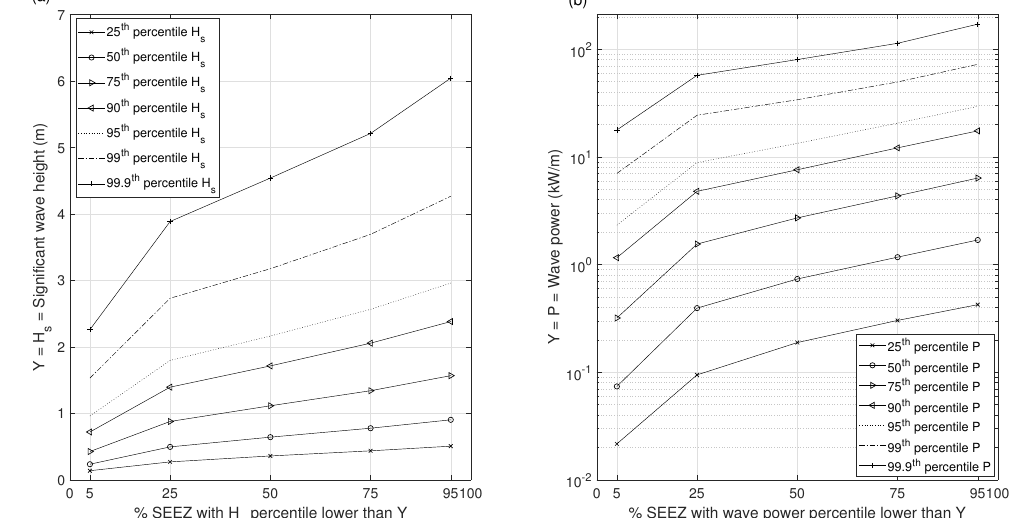
Figure 5. Percentile values for ice-free significant wave height (in ( a )) and wave power P (in ( b )) are shown against the spatial percentile for the SEEZ indicating how many percentage points of the region have the presented significant wave height or wave power